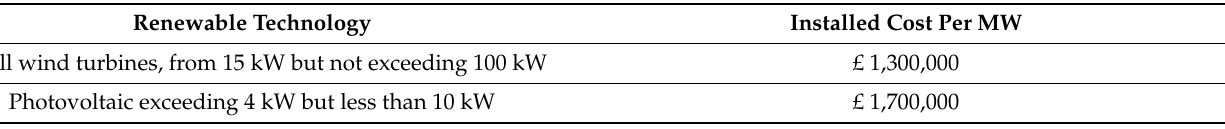
Table 3. Assumptions on cost per installed MW of